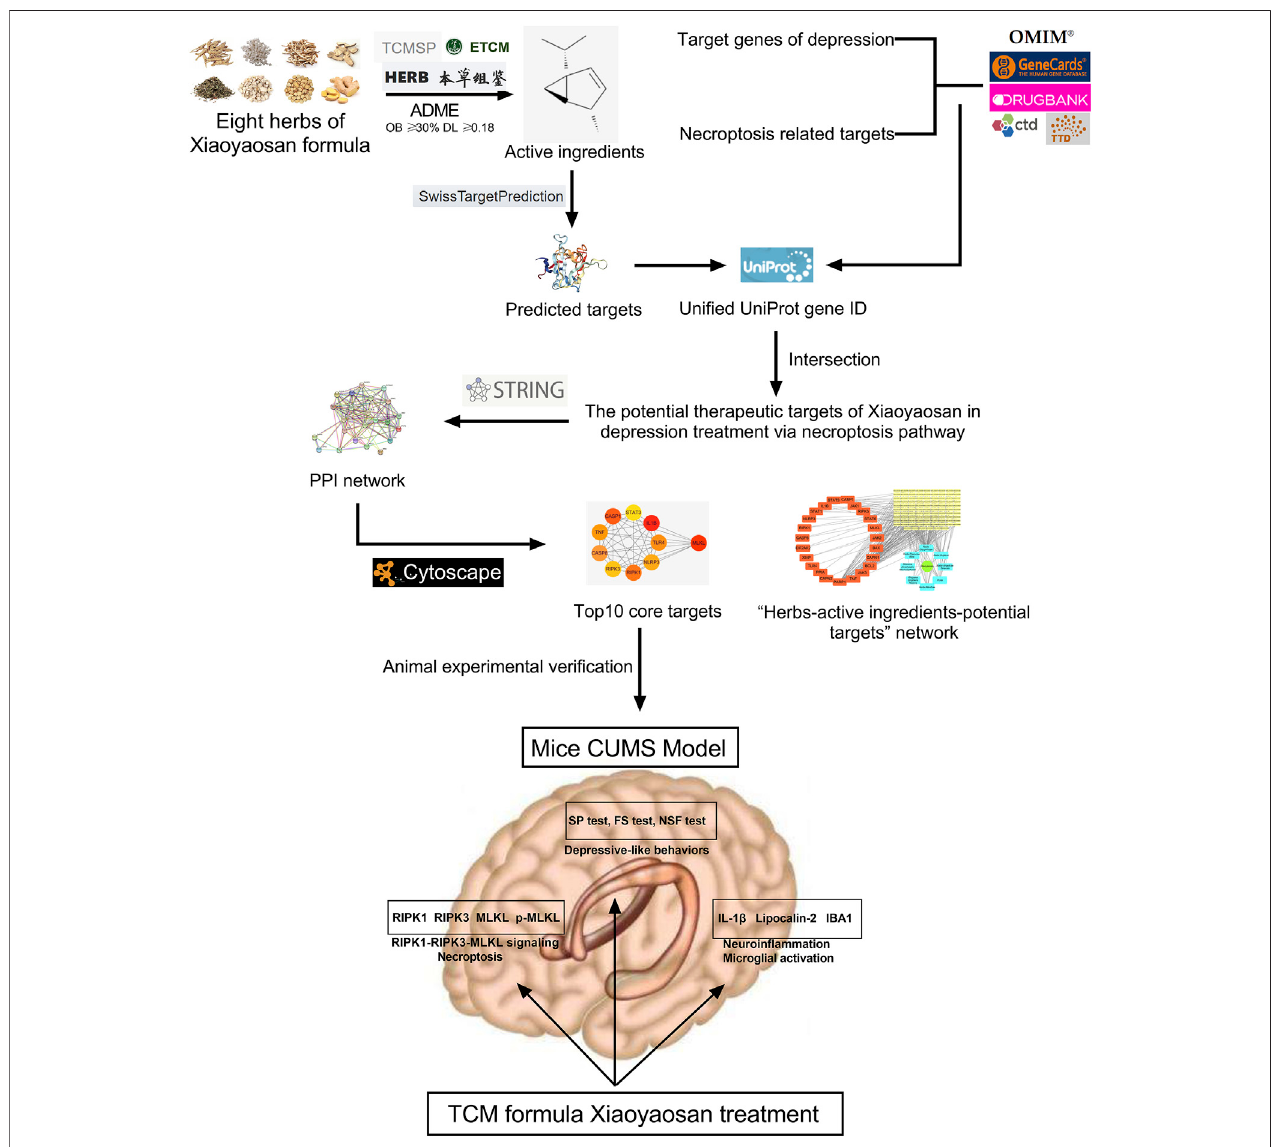
FIGURE 1 | Flow chart of network pharmacological analysis and experimental study of Xiaoyaosan for depression treatment through necroptosis pathway.